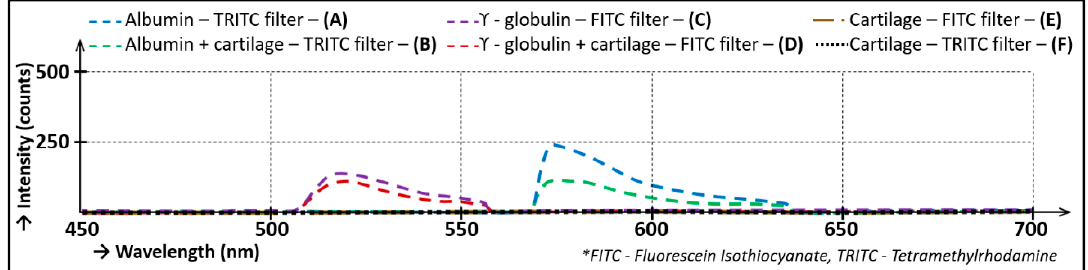
Figure 9. Lubricant emission.